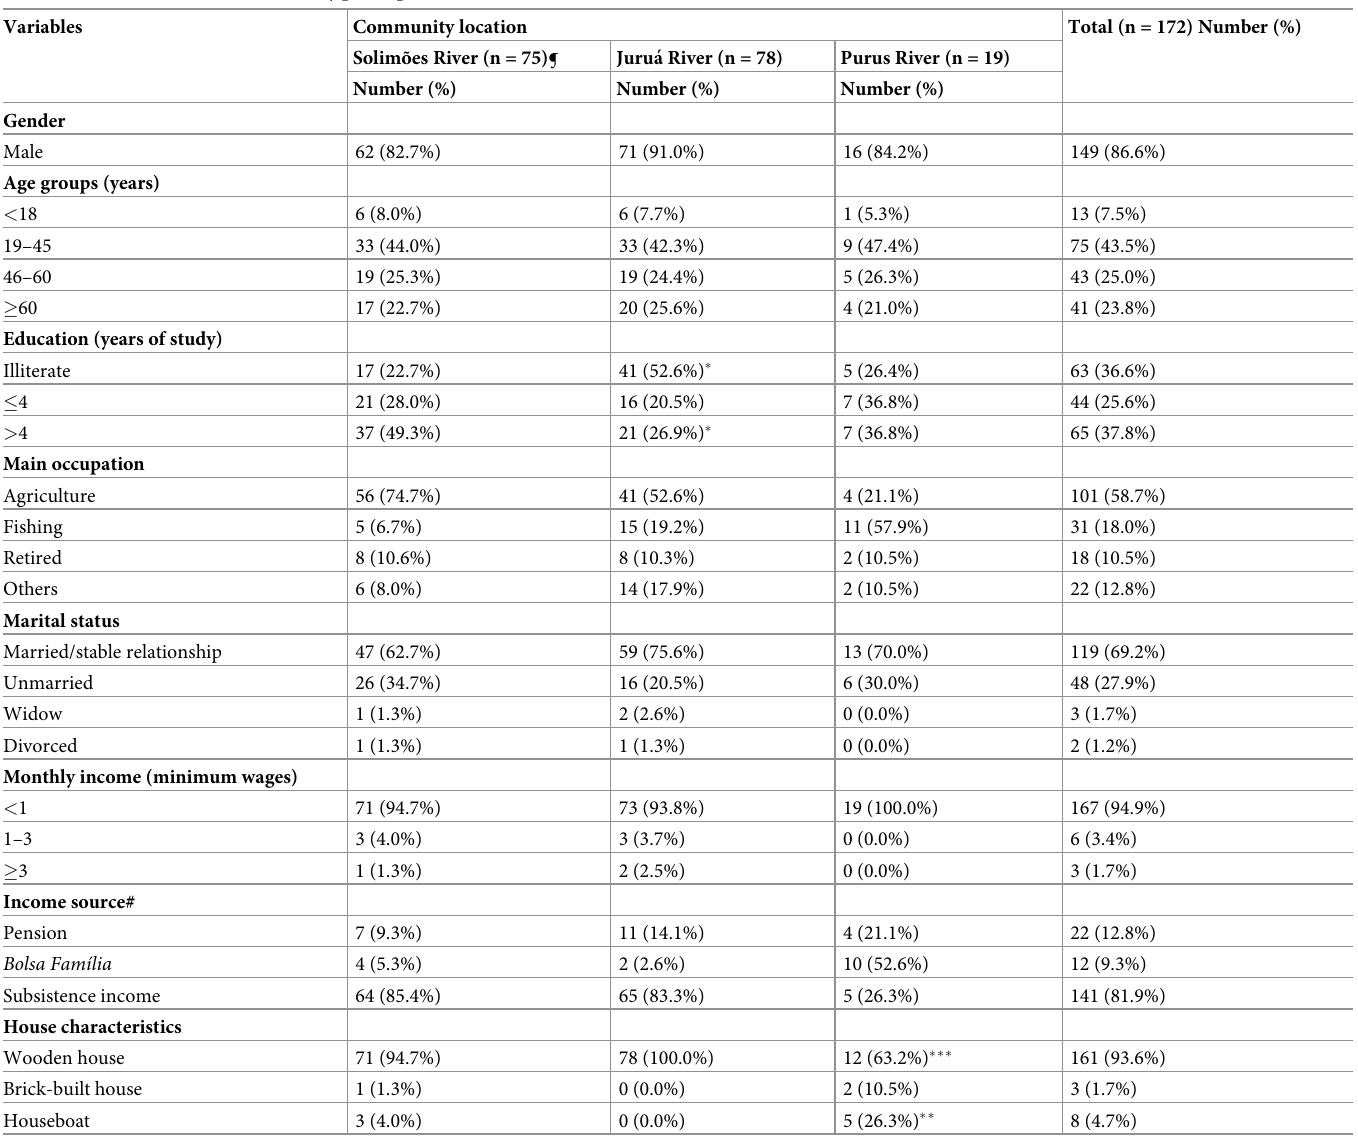
Table 1. Characteristics of the 172 study